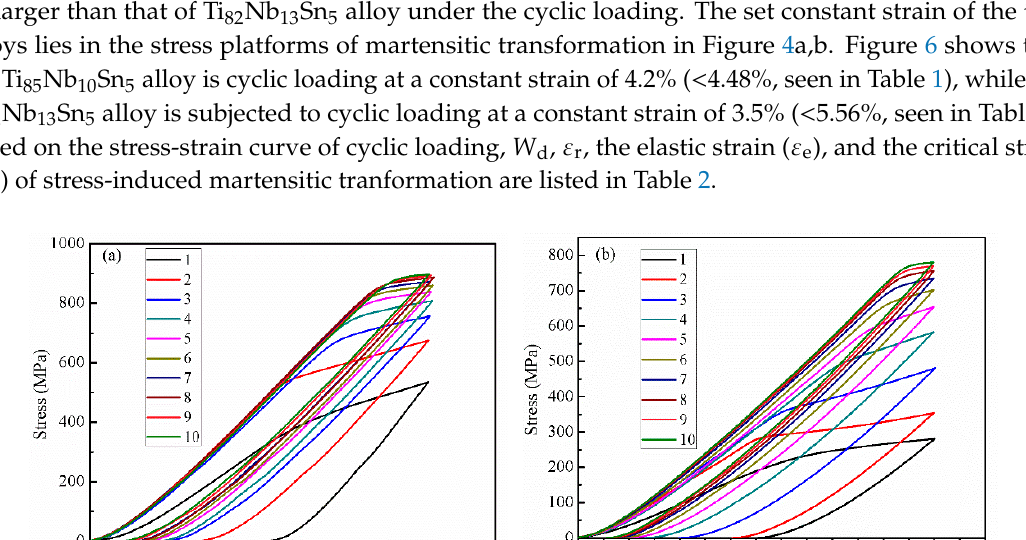
Table 2. The cyclic dissipation energy ( W d ), residual strain ( ε r ), elastic strain ( ε e ), and critical stress ( σ m ) of martensitic tranformation.